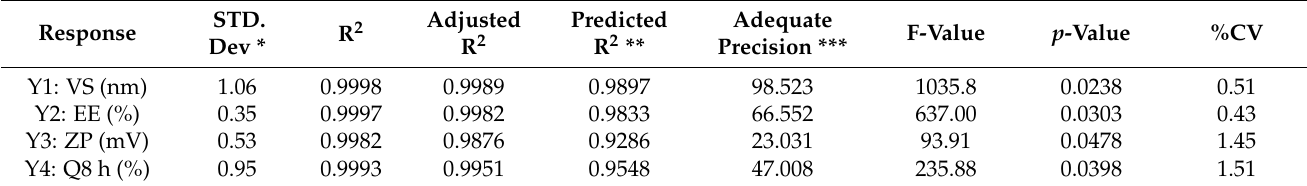
Table 3. 2 3 full factorial design results.